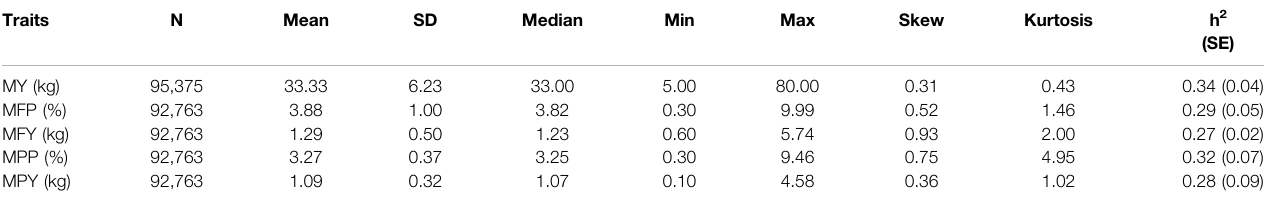
TABLE 1 | Descriptive statistics of test-day records and estimated heritability of 305-day performance of the milk-related traits in the study population.